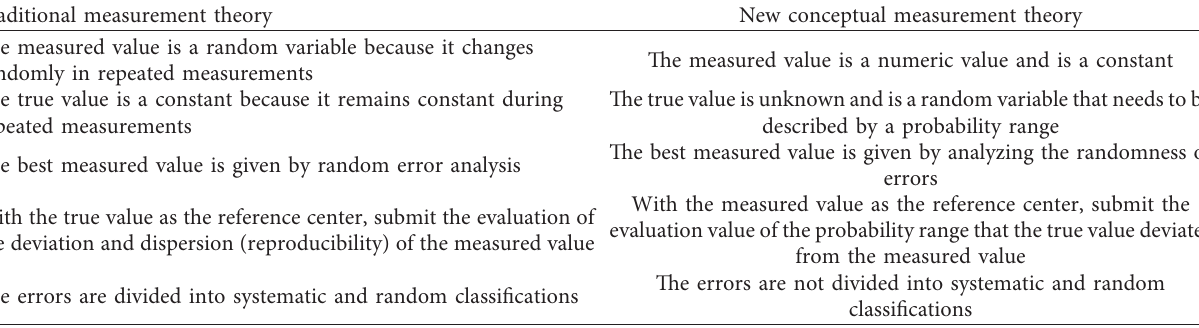
Table 6: Conceptual logic difference between the two